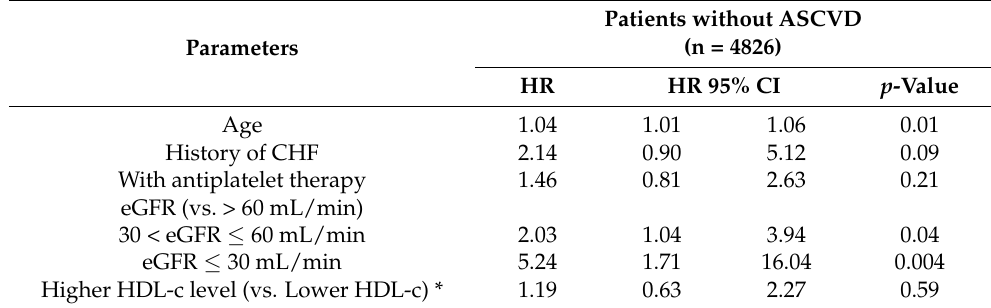
Table 4. Multivariate Cox PH model for predicting MACE among patients without